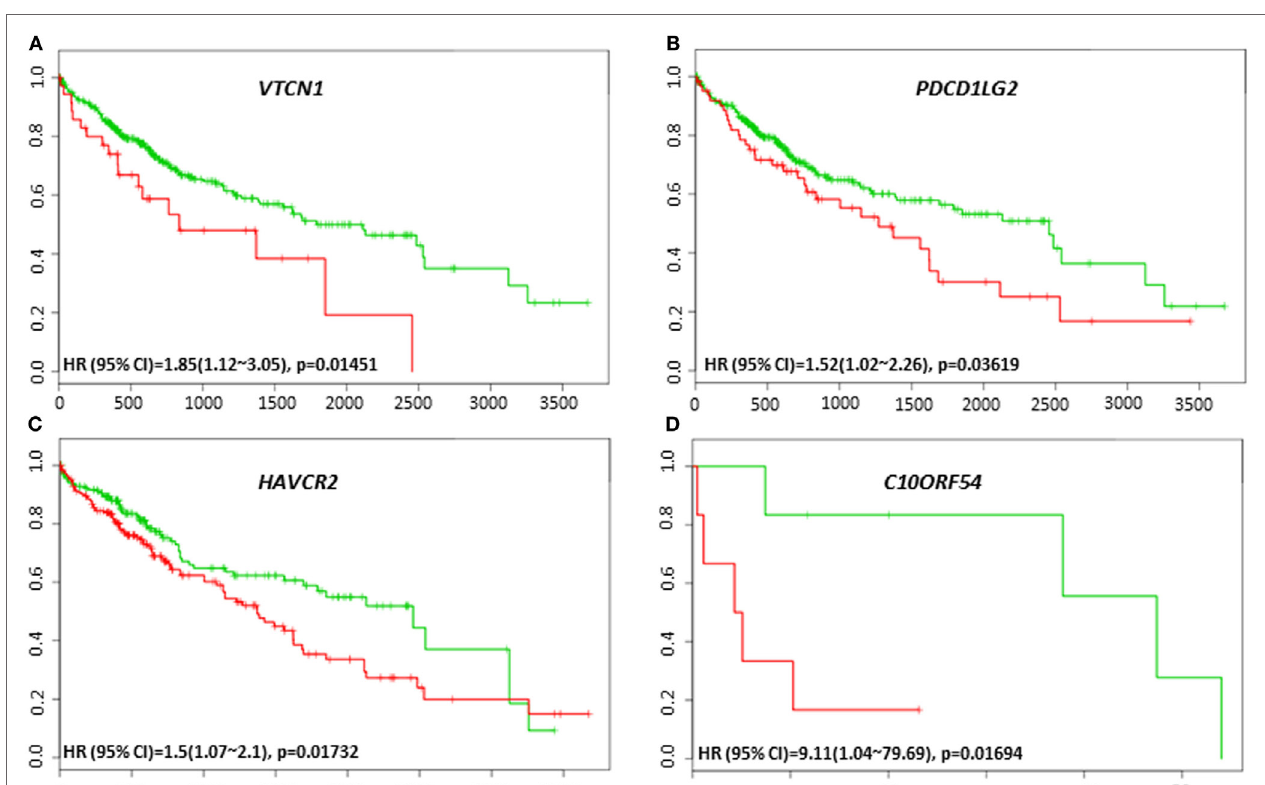
FigUre 3 | Relationship of immune modulators and survival in HCC patients. Kaplan–Meier survival curves from SurvExpress for the analysis of survival and gene expression of (a) VTCN1 , (B) PDCD1LG2 , (c) HAVCR2 , and (D) C10ORF54 in HCC patient samples. Green curve represents low-risk group while red curve represents high-risk group. The study time (months) is presented in the x -axis. The insert shows the hazard ratio, confidence interval, and Log-Rank Equal Curves p value. Markers ( + ) represent censoring